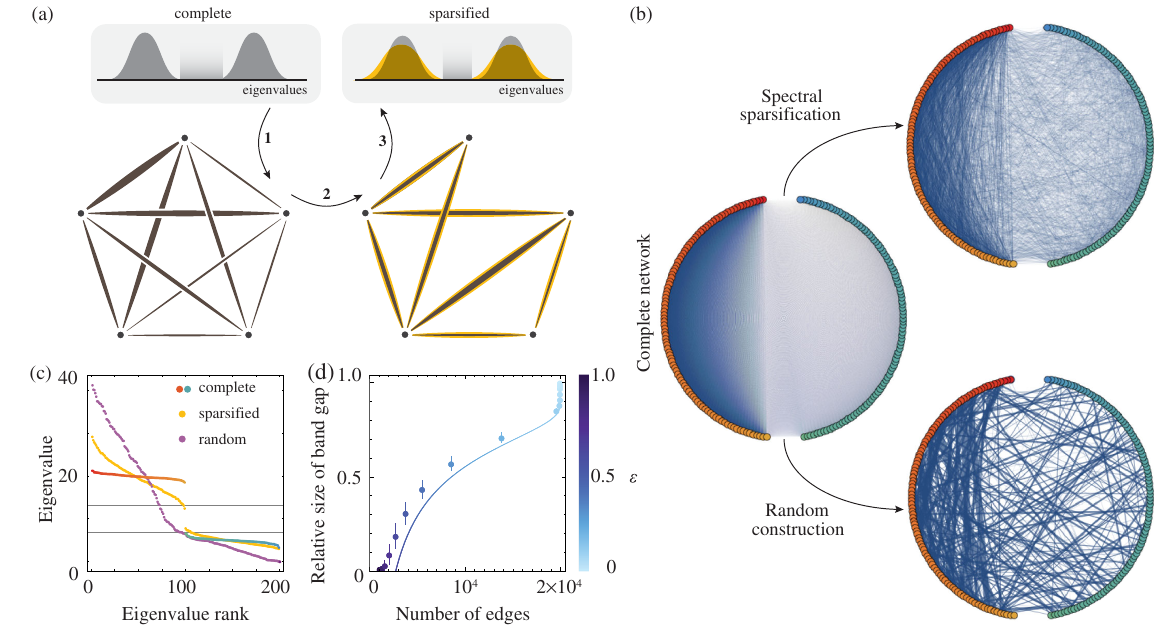
FIG. 1. Designing networks from spectra. (a) Schematic of DBG network construction. Given a spectrum of eigenvalues distributed in two (or more) groups, we build a graph with non-negative edge weights that realizes this spectrum exactly (1). Sparsification of this complete DBG network with the Spielman-Srivastava [33] algorithm (2) yields a new network with wider eigenvalue distributions and a smaller gap (3). (b) Example graphs used in applications below: Starting from a DBG graph on 200 vertices with 100 eigenvalues set to independent and identically distributed (IID) N ð 5 ; 0 . 25 Þ and 99 set to IID N ð 20 ; 0 . 25 Þ (left), sparsification with ϵ ¼ 0 . 5 creates a new graph (top) with the number of edges reduced from 19900 to 3758. As a control, we also compare to a gapless random graph (bottom) with 362 edges and the same weighted vertex degrees as the original DBG graph (Appendix C). (c) The eigenvalues for the graphs in (b). The mode on the complete DBG network with the k th largest nonzero eigenvalue is supported on the first k þ 1 vertices, counted counterclockwise from the top red vertex, and highly localized on vertex k þ 1 , which is colored to match in (b). Gray lines indicate the borders of the unstable region for the Swift-Hohenberg model with the parameters used in Fig. 3. (d) Sparsified networks retain a significant gap even for relatively large ϵ . Each point shows the mean number of edges and gap size at fixed ϵ between 1 (left) and 0.01 (right), starting from a graph on 200 vertices designed to have 100 × eigenvalue 5 and 99 × eigenvalue 20. The solid curve shows the ϵ . Sample size is 1000 for ϵ ≥ 0 . 1 and 300 for ϵ < 0 . 1 . Error bars are (cid:2) 1 standard worst-case gap estimate, reduction by a factor of 1 − 5 3 deviation; horizontal error bars are smaller than the marker